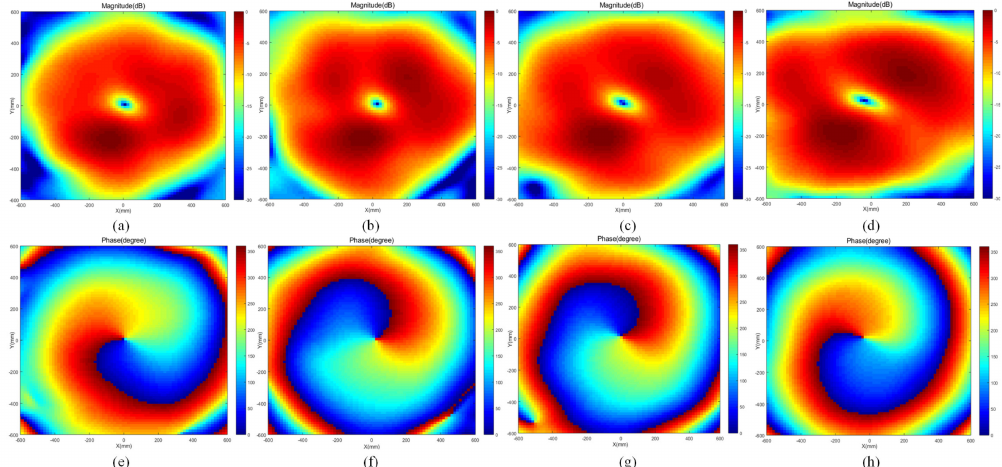
Figure 8. Measured near-field amplitude and phase distributions on the sampling plane vertical to the scanning beams approximately 25 wavelengths away from the reconfigurable surface. Amplitude distributions of OAM scanning beams with the mode l = 1 at ( a ) 15 ◦ , ( b ) 30 ◦ , ( c ) 45 ◦ , and ( d ) 60 ◦ . Phase distributions of OAM scanning beams with the mode l = 1 at ( e ) 15 ◦ , ( f ) 30 ◦ , ( g ) 45 ◦ , and ( h ) 60 ◦